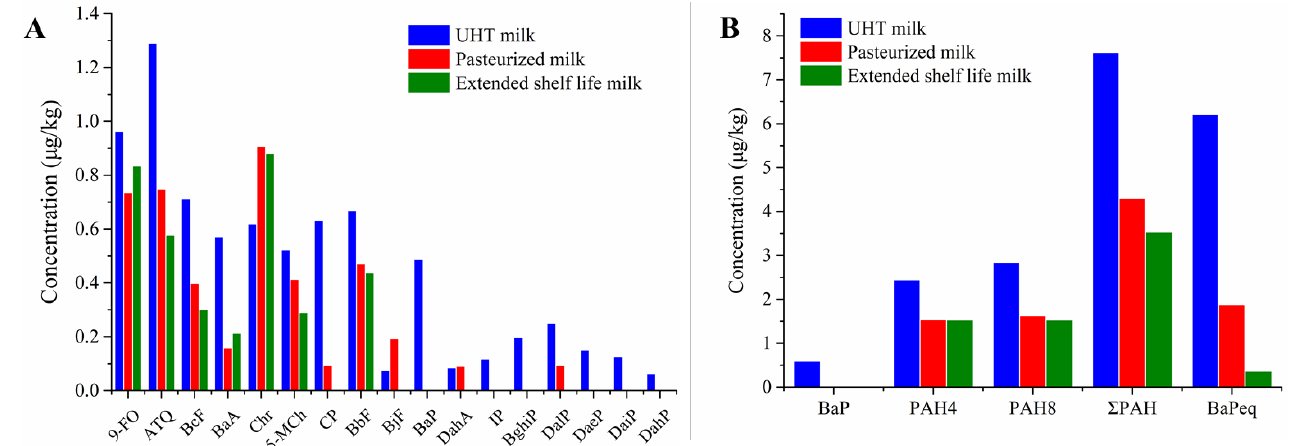
Figure 3. PAH concentrations in milks with different sterilization processes. ( A ) individual PAH analytes. ( B ) Concentrations of BaP, PAH4, PAH8, 17 PAHs, and BaPeq.